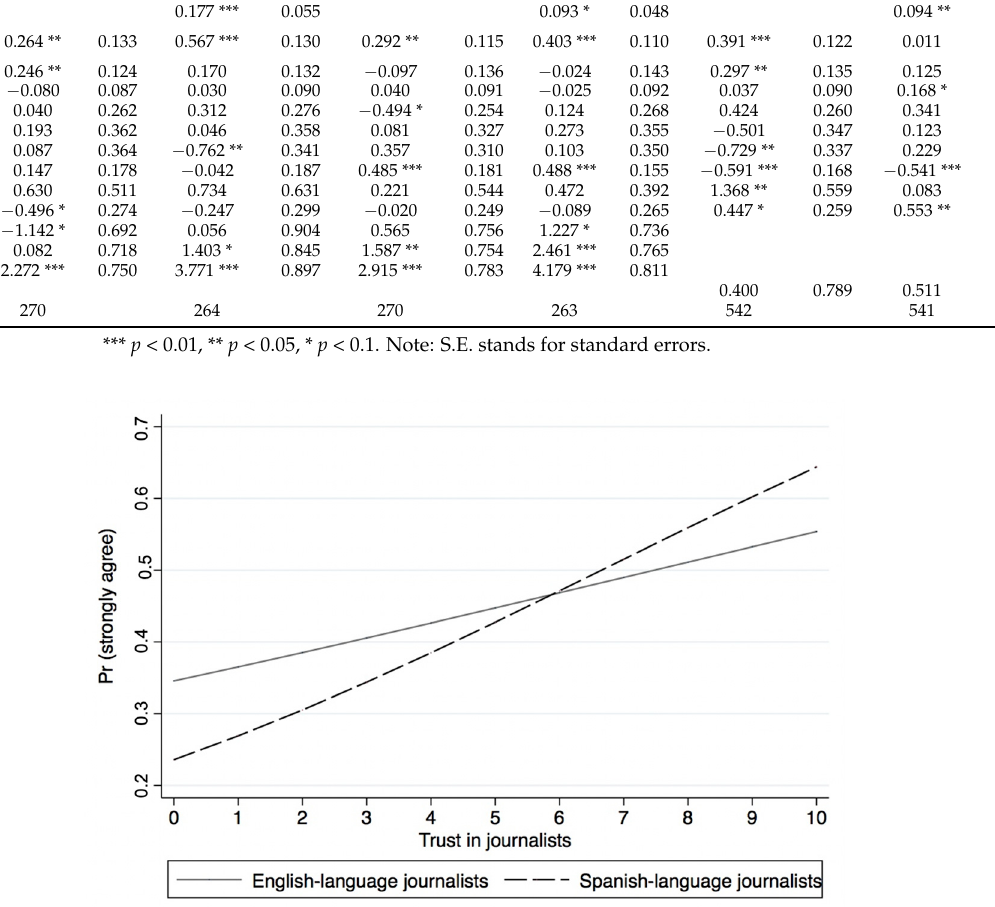
Table 2. Models on attitudes towards information provided by state and local officials and collective health .